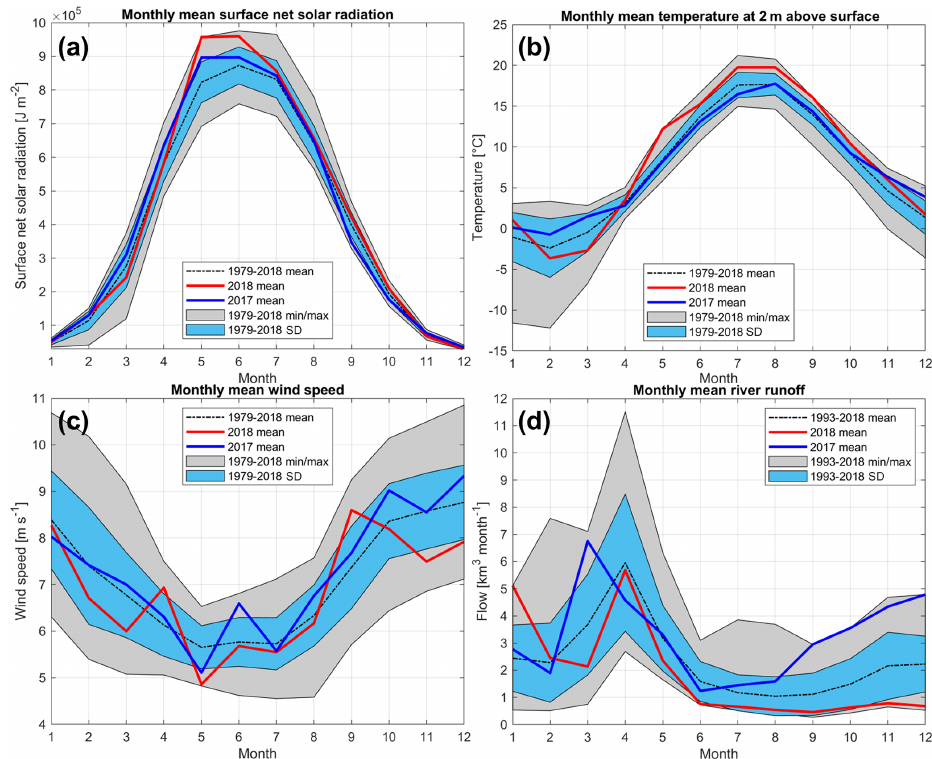
Figure 6. Courses of monthly mean, minimum and maximum, and standard deviation of (a) surface radiation, (b) air temperature, and (c) wind speed for the period of 1979–2018 and (d) river runoff for the period of 1993–2018. The monthly mean values of listed parameters for 2017 and 2018 are shown as blue and red lines, respectively. For meteorological parameters, ERA5 data are used from the central Gulf of Riga (see the location of the grid cell in Fig. 1).